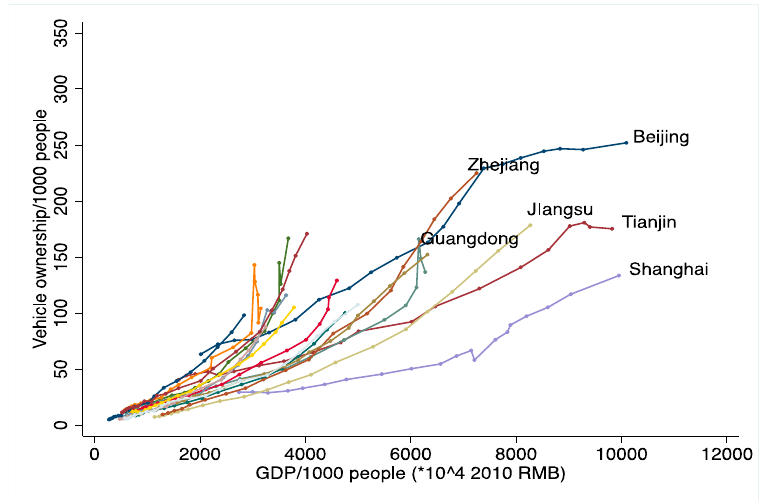
Figure 3. Vehicle ownership per 1000 people versus GDP per 1000 people in China for 1997–2016. Note: GDP data of each province is deflated by the CPI, with 2010 as the base year. All the data here comes from the China Statistical Yearbook (1998–2017).